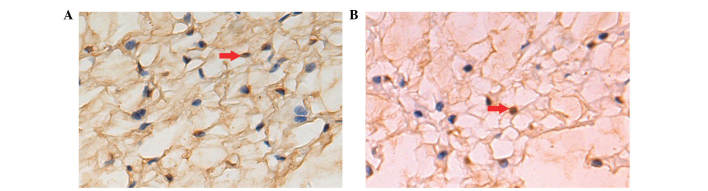
Photomicrographs showing cell apoptosis in the disc samples. TUNEL staining was used to investigate the cell apoptosis of the disc at 12 weeks. The arrow indicates an apoptotic cell. Original magnification, ×400.